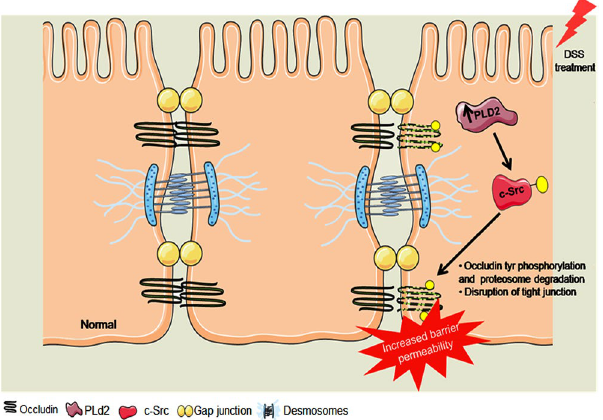
Figure 7. Mechanism of epithelial barrier integrity regulation by PLD2. DSS treatment upregulates the expression of PLD2 in colon epithelial cells, which activates c-SRC. c-SRC is a tyrosine kinase that interacts with the tight junction protein occludin. Activated c-Src phosphorylates occludin at the tyrosine residues and targets it for proteasome-mediated degradation. Dissociation of occludin from the membrane causes an increase in barrier permeability, which leads to increased inflammation. Graphical illustration was drawn using the images from Servier Medical Art by Servier with slight modifications (http://www.servier.com/Powerpoint-image- bank,